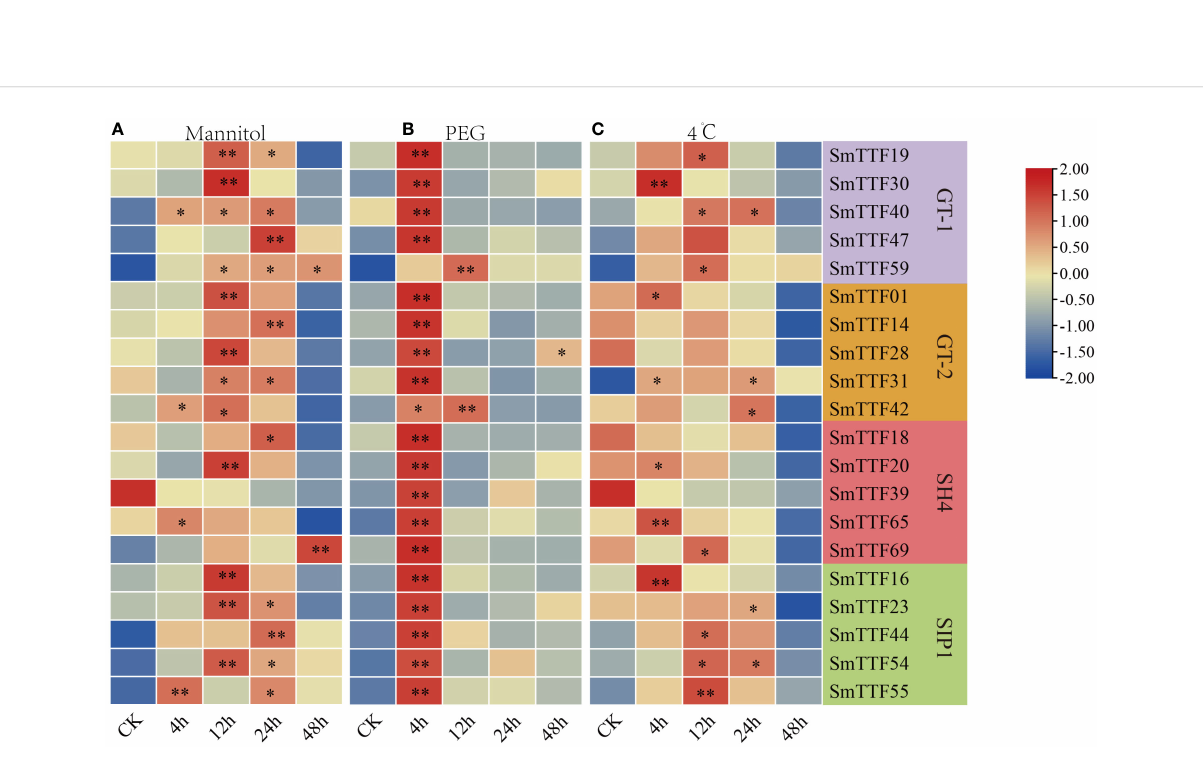
FIGURE 8 The expression pro fi les of 20 selected trihelix genes in S. matsudana under other abiotic stresses by qRT-PCR. (A) The expression pro fi les under 200 mM mannitol solutions. (B) The expression pro fi les under 20% PEG6000. (C) The expression pro fi les under 4°C. All roots from plants were treated for 4 h, 12 h, 24 h and 48 h. The fold change in expression level is depicted by a heatmap. Data are average values ± SD ( n = 3) calculated from three independent experiments. Asterisks indicate signi fi cant differences from WT (* p < 0.05, ** p < 0.01 by Student ’ s t